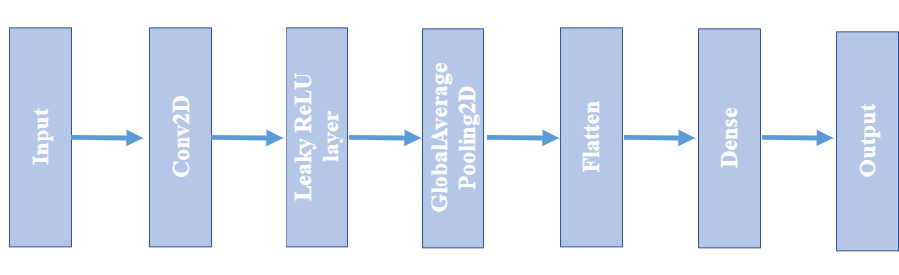
Figure 7. CNN2D model core